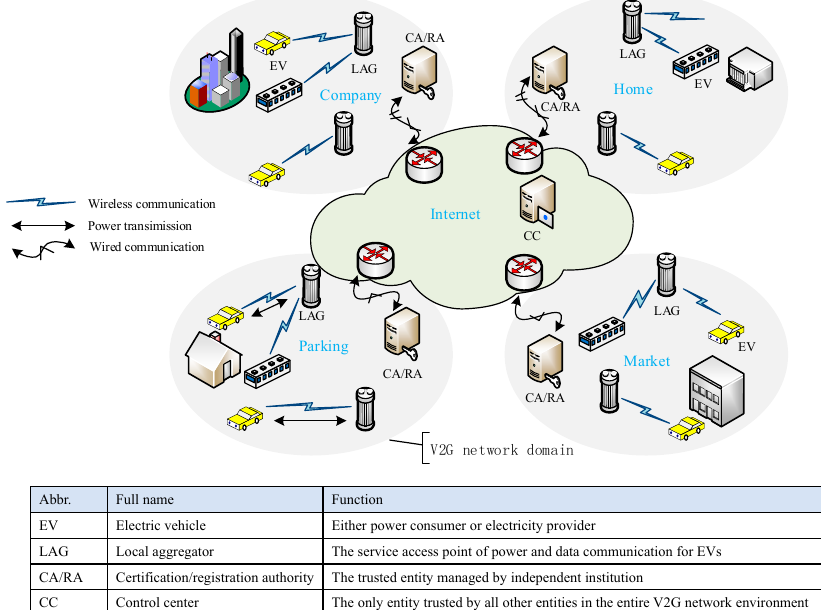
Figure 1. An illustration of vehicle-to-grid (V2G) network environment.